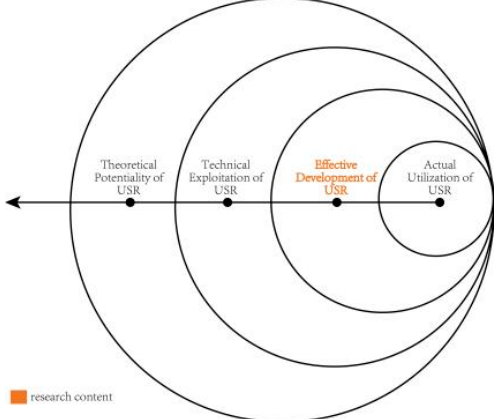
Figure 8. Subordination and inclusion relation of USR.